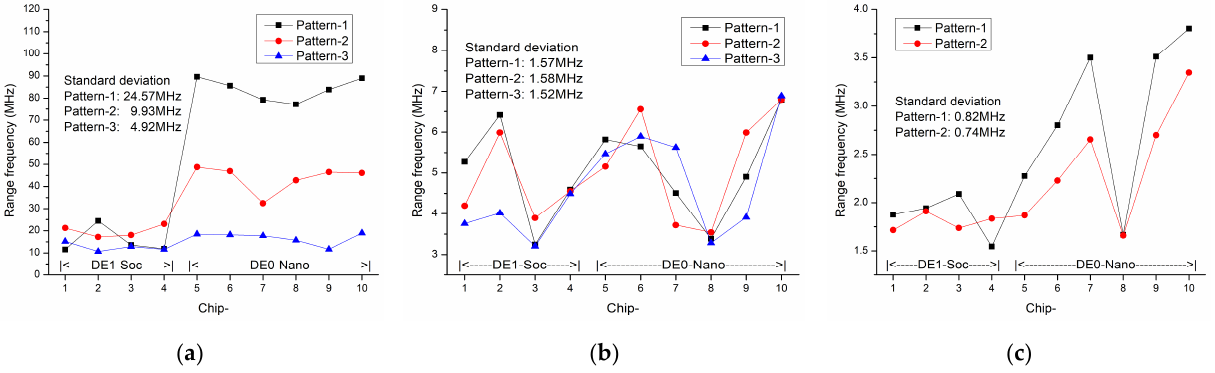
Figure 11. Frequency range and standard deviation in all chips: ( a ) RO5, ( b ) RO11, ( c ) RO20.